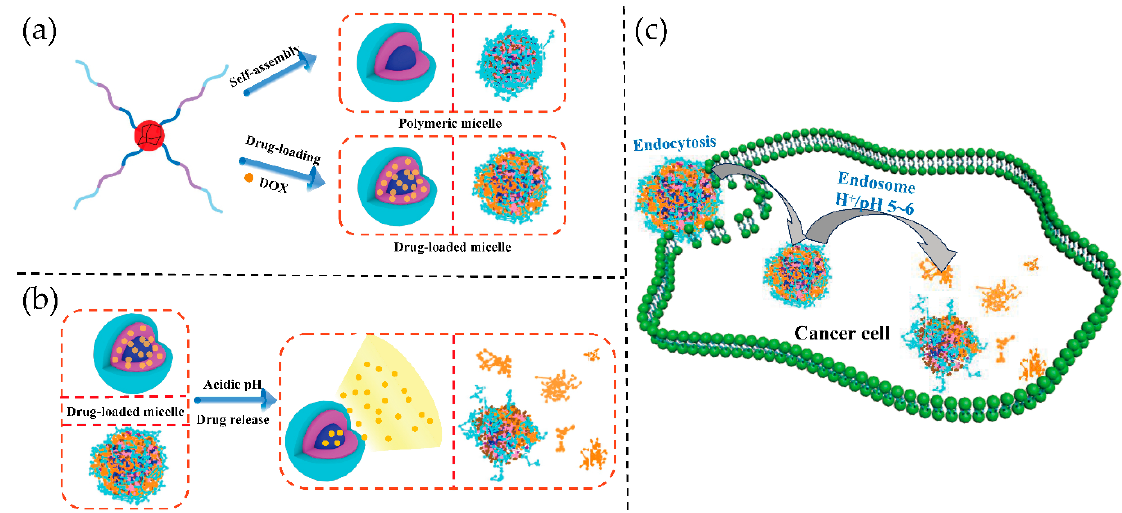
Figure 1. ( a ) Self-assembled behavior of star-shaped polymeric micelles and drug-loaded micelles. ( b ) Schematic illustration of controlled drug release triggered by pH for star-shaped drug-loaded micelles. ( c ) Internalization of DOX-loaded micelles by a cancer cell and the controlled release of DOX triggered by pH.